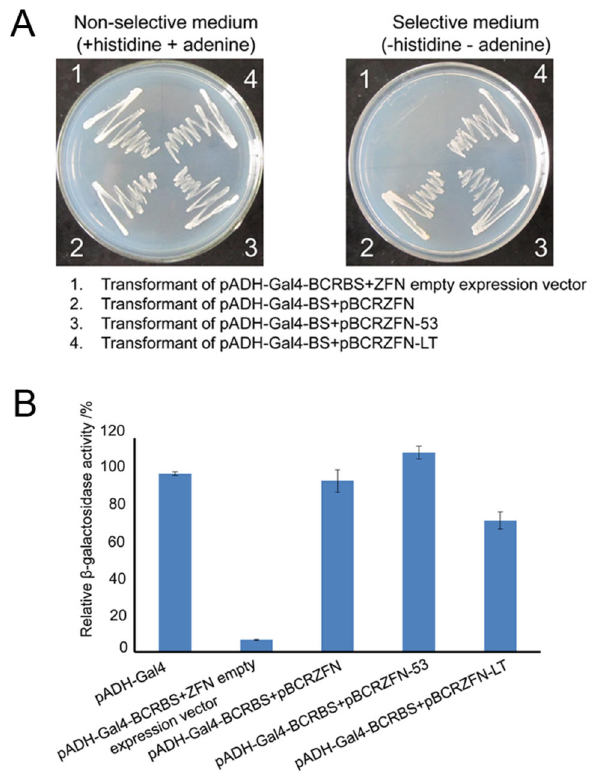
Figure 2. Detection of the function of ZFNs with different distances between the ZFP and FokI domains. (A) Detection of auxotrophic selection pressure. Yeast strain AH109 was transformed with a reporter plasmid and different ZFNs. Transformed yeast colonies were spotted? on non- selective medium and selective medium, and they were grown at 30°C for 3 days. (B) Relative β-galactosidase activity assay. Three independent transformants were assayed in each group. The transformants of pADH-Gal4 were the positive control, and β-galactosidase activity was set to 100%. Error bars represent the standard deviation from 3 independent experiments.